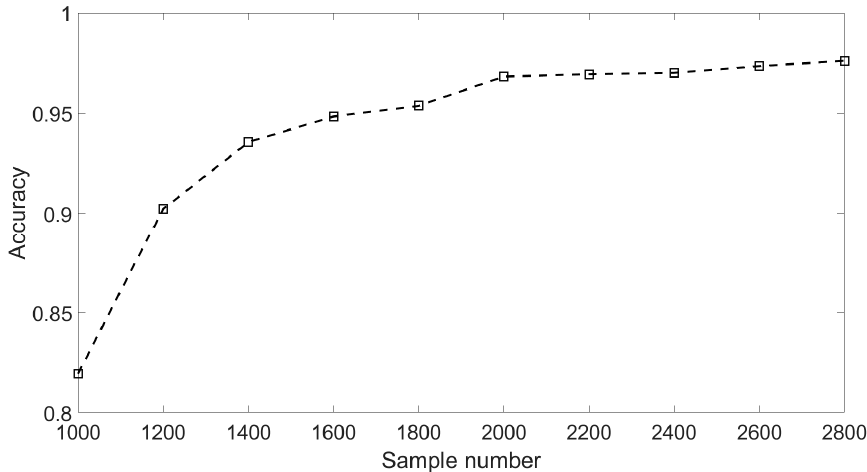
Figure 10. Results of different sample numbers.